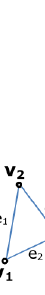
Figure 2. A BT-Graph of the dynamic sensor fiel